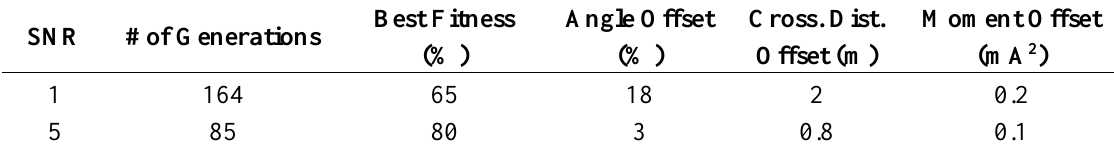
Table 1. Specific points in the cumulative distribution function of the discrepancy between the true crossing point and the GA result (in